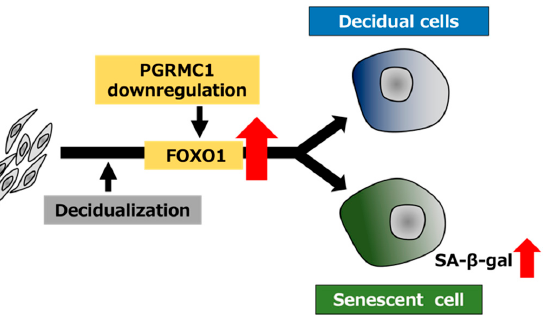
Figure 6. Schematic summary of PGRMC1 downregulation-mediated cellular senescence in decid- ualizing ESCs. The decrease in the PGRMC1 level in the secretory phase of the menstrual cycle may promote decidualization and concomitantly induce cellular senescence by upregulating FOXO1 ex- pression in ESCs.